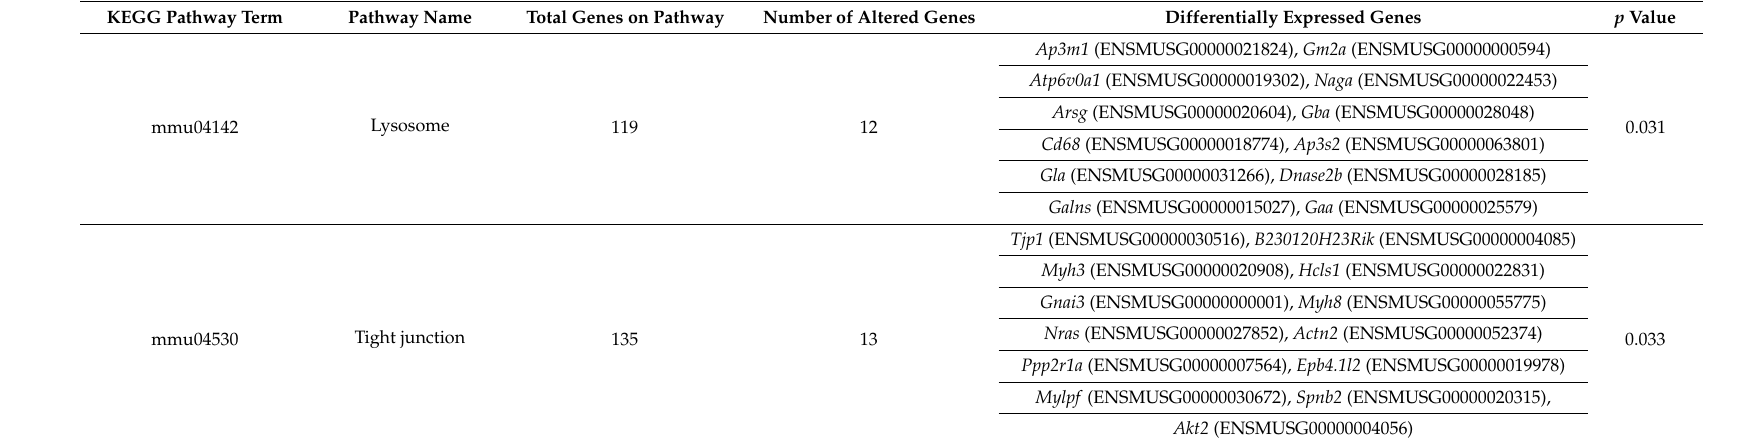
Table 2. KEGG pathways in the fetal liver altered by maternal folate depletion during pregnancy 1